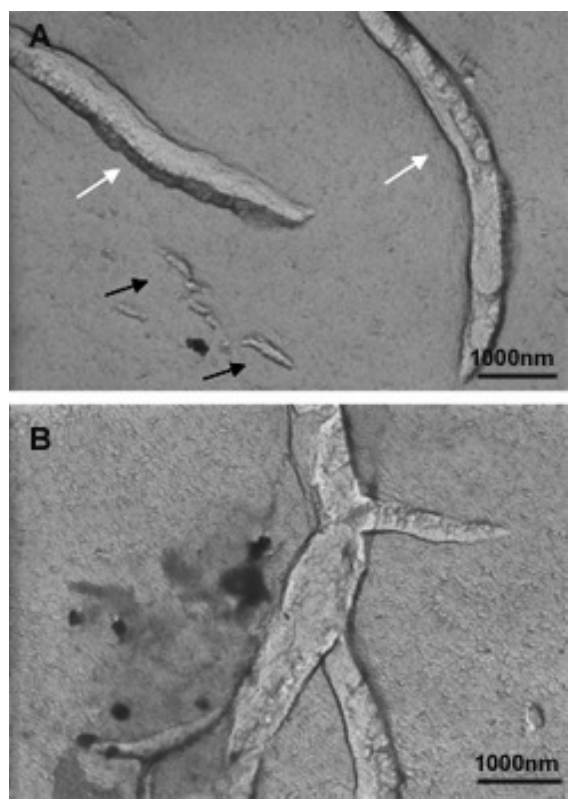
Figure 17. Micrographs of bicellar sample containing Cer at 40 °C. A) and B) represent two different regions of the same sample. In image A the arrows indicate the tubular objects with about 500 nm (black arrows) and 4000 nm (white